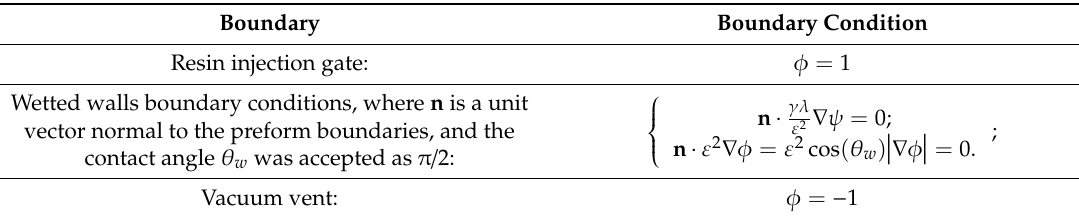
Table 1. The boundary conditions of the phase field